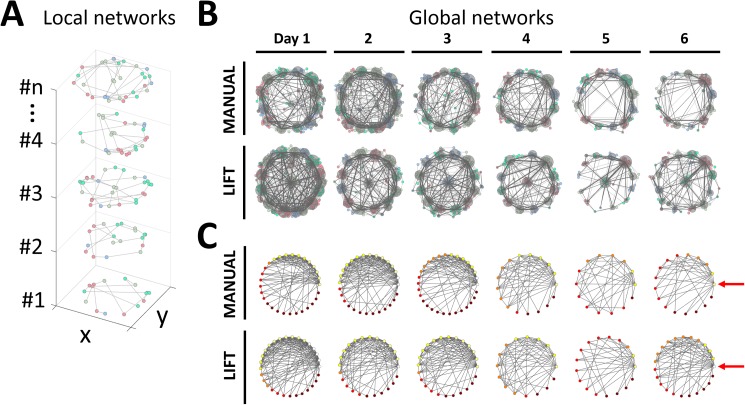
Visualization of temporal changes in the search networks during spatial learning in the MANUAL and LIFT entries.(A) Exmples of local networks from an individual mouse on Day 1 of the LIFT entry. Local networks of mouse #1 to mouse #n generated by the dynamic node generation method are shown in a three-dimentional coordinate system. One local network was generated following a single trial of a particular mouse. The x- and y-axes indicate the plane coordinates, including the arena. The z-axis indicates the sample numbers. The small dots and light gray lines indicate local nodes and links, respectively. One of four colors is assigned to each local node in accordance with a global node associated with the local node (see below). (B) Temporal changes in the global networks in the MANUAL and LIFT entries during spatial learning. Network structures of exploratory behaviors formed by the dynamic node generation method in the MANUAL and LIFT entries are plotted in the upper and lower rows, respectively. Each column corresponds to a single training day. Small colored dots and light gray lines represent nodes and links in the local networks. The local nodes are represented by any one of four colors. Note that this color-coding simply distinguishes geometrically adjacent local nodes belonging to different global nodes using different colors. To describe the global network structure, all local networks of the same entry group on a single training day, such as Fig 6A, were projected on plane coordinates. Dark gray circles and dark gray lines are global nodes and links in global networks, respectively. The magnitude of each global node was determined using logarithmic transformation of the number of local nodes assigned to each global node. A similar procedure was performed to determine global links from sets of local links. The network structure simplified as spatial learning was established. (C) Topological expression of global networks. The layout of rows and columns are the same as in Fig 6B. Global nodes were sorted by rank-order of degree (Mi) and plotted on polar coodinates, so that the node with the highest degree was located at 0 degrees while the lowest one was located at 360 degrees. The locations of the global nodes that are most densely linked are highlighted by red arrows. Circles and lines represent global nodes and links, respectively. Each sorted global node is represented by any one of five colors by the magnitude of degree; white (Mi ≥ 12), yellow (12 > Mi ≥ 9), orange (9 > Mi ≥ 6), red (6 > Mi ≥ 3), brown (3 > Mi).